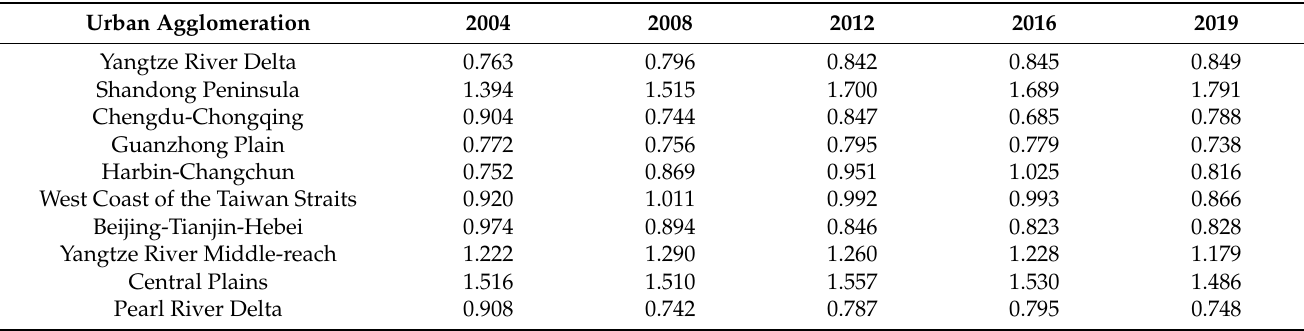
Table 2. Polycentricity of top ten UAs in particular